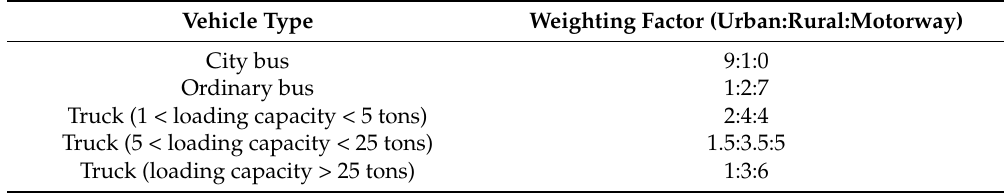
Figure 2. Comparison of the World Harmonized Vehicle Cycle (WHVC) and Korean-World Harmonized Vehicle Cycle (K-WHVC) [21]. Table 3. Weighting factors of the driving cycles.